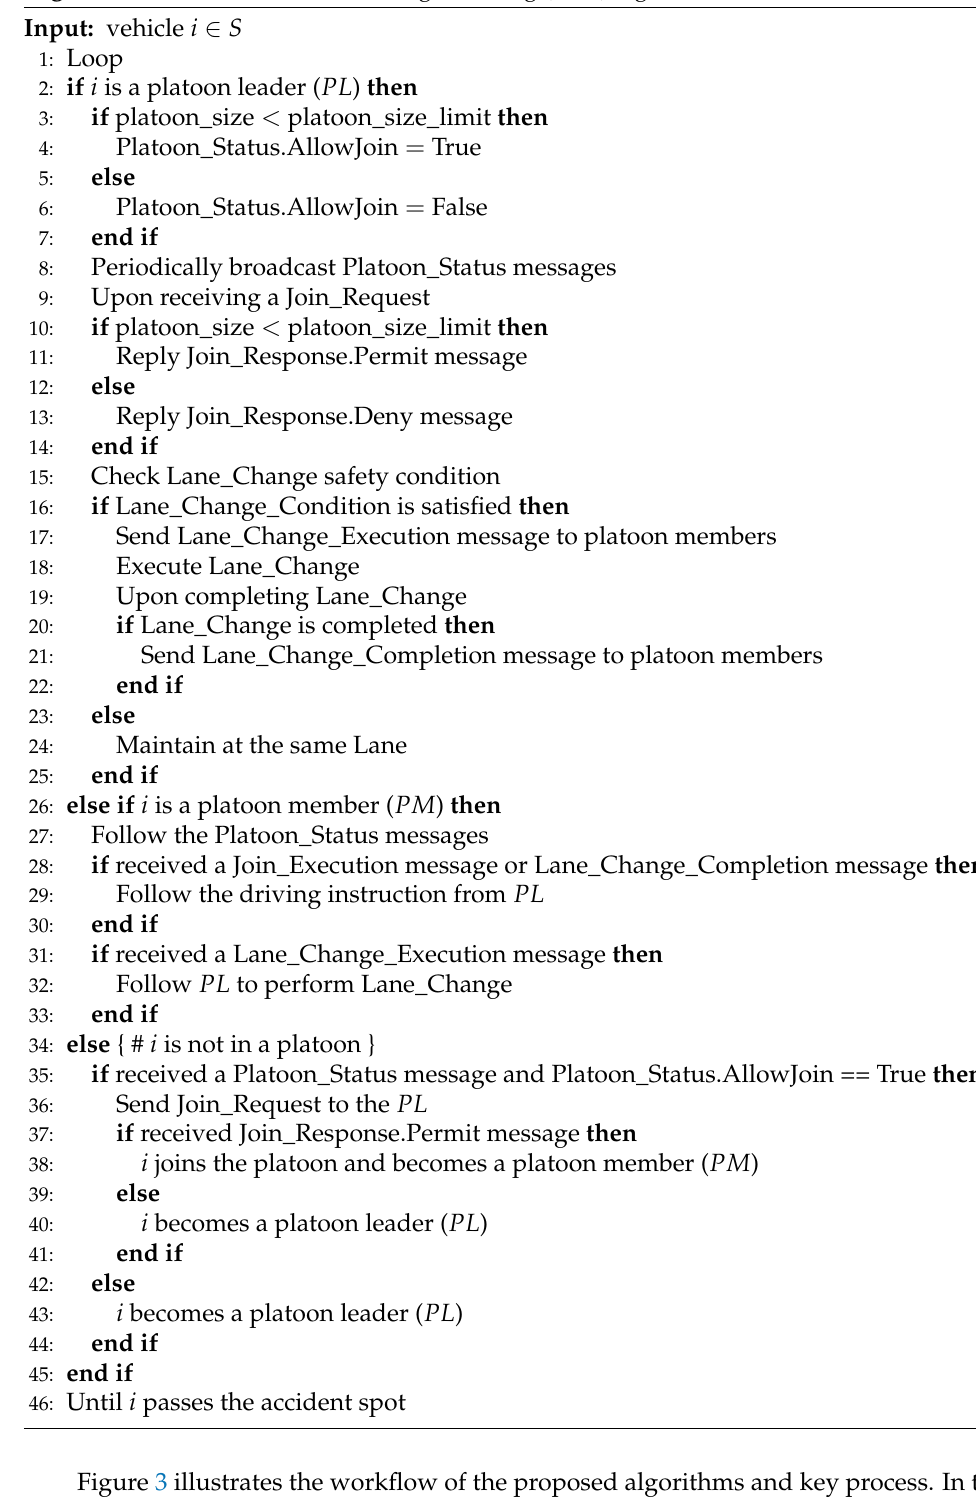
Algorithm 1 Coordinated Platooning Planning (CPP)